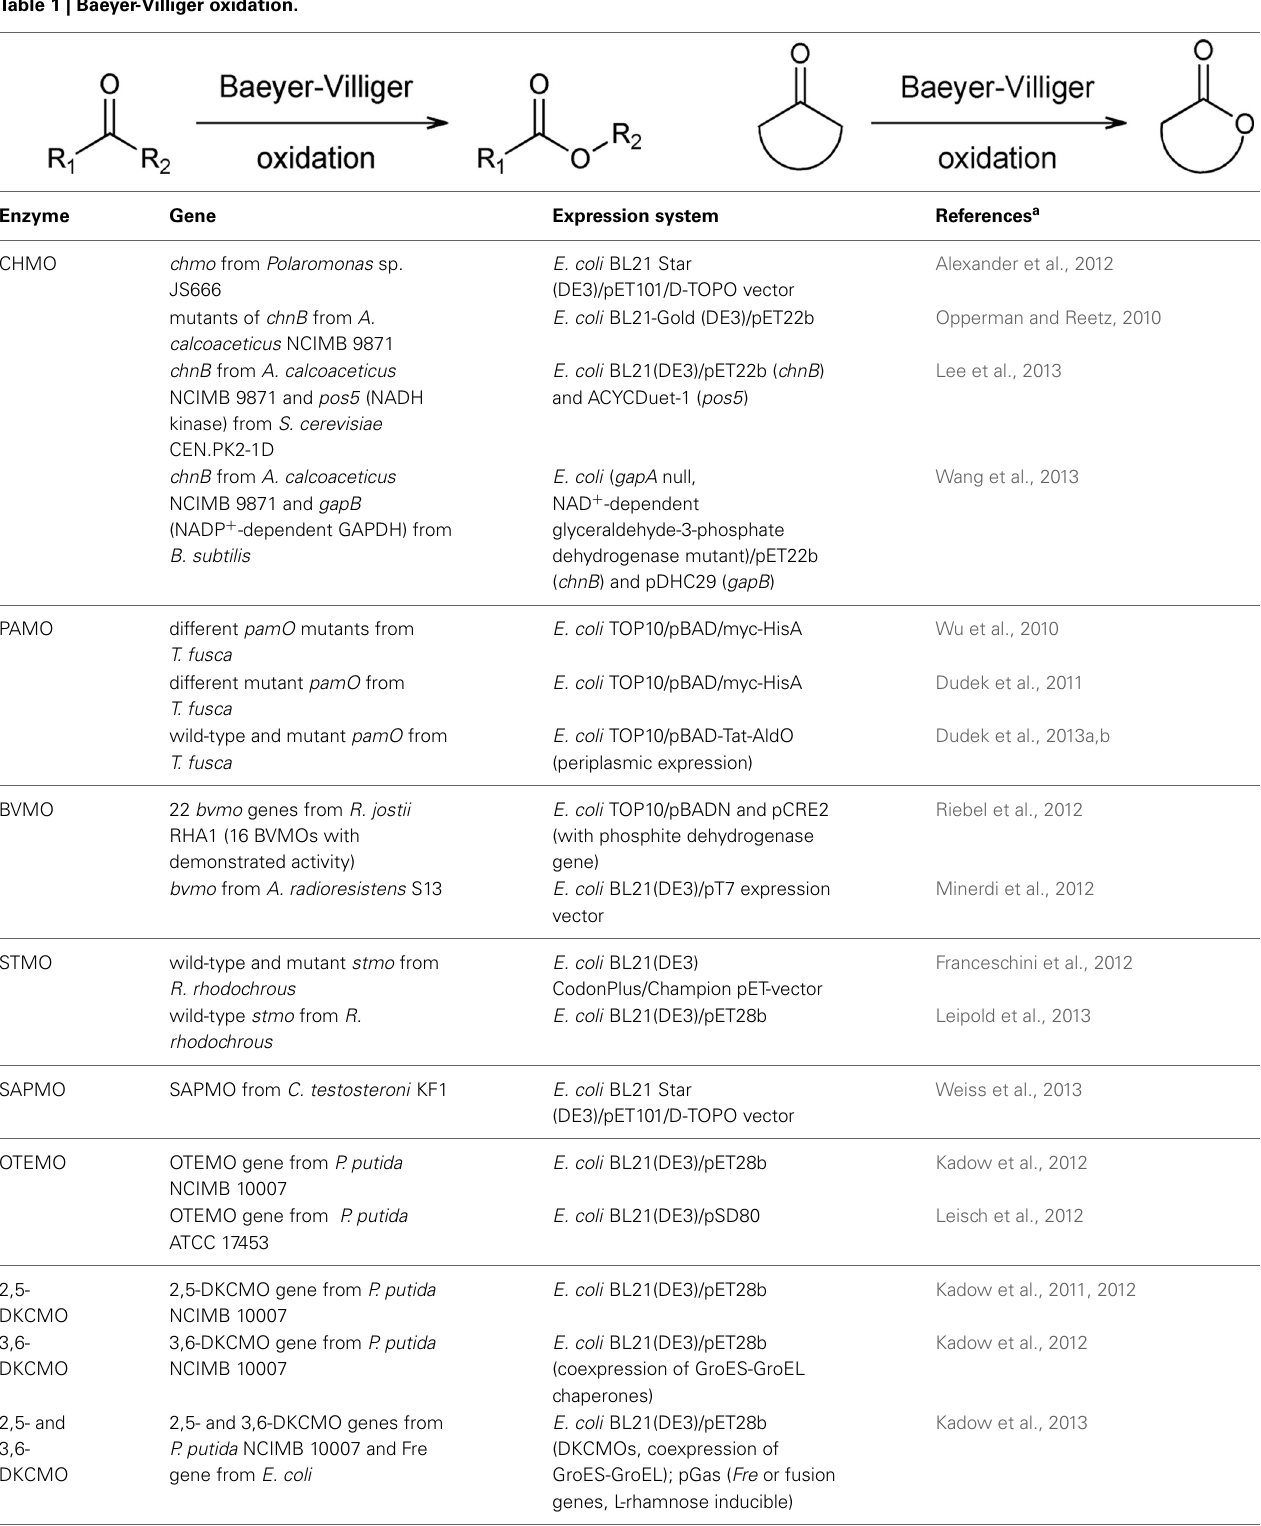
Table 1 | Baeyer-Villiger